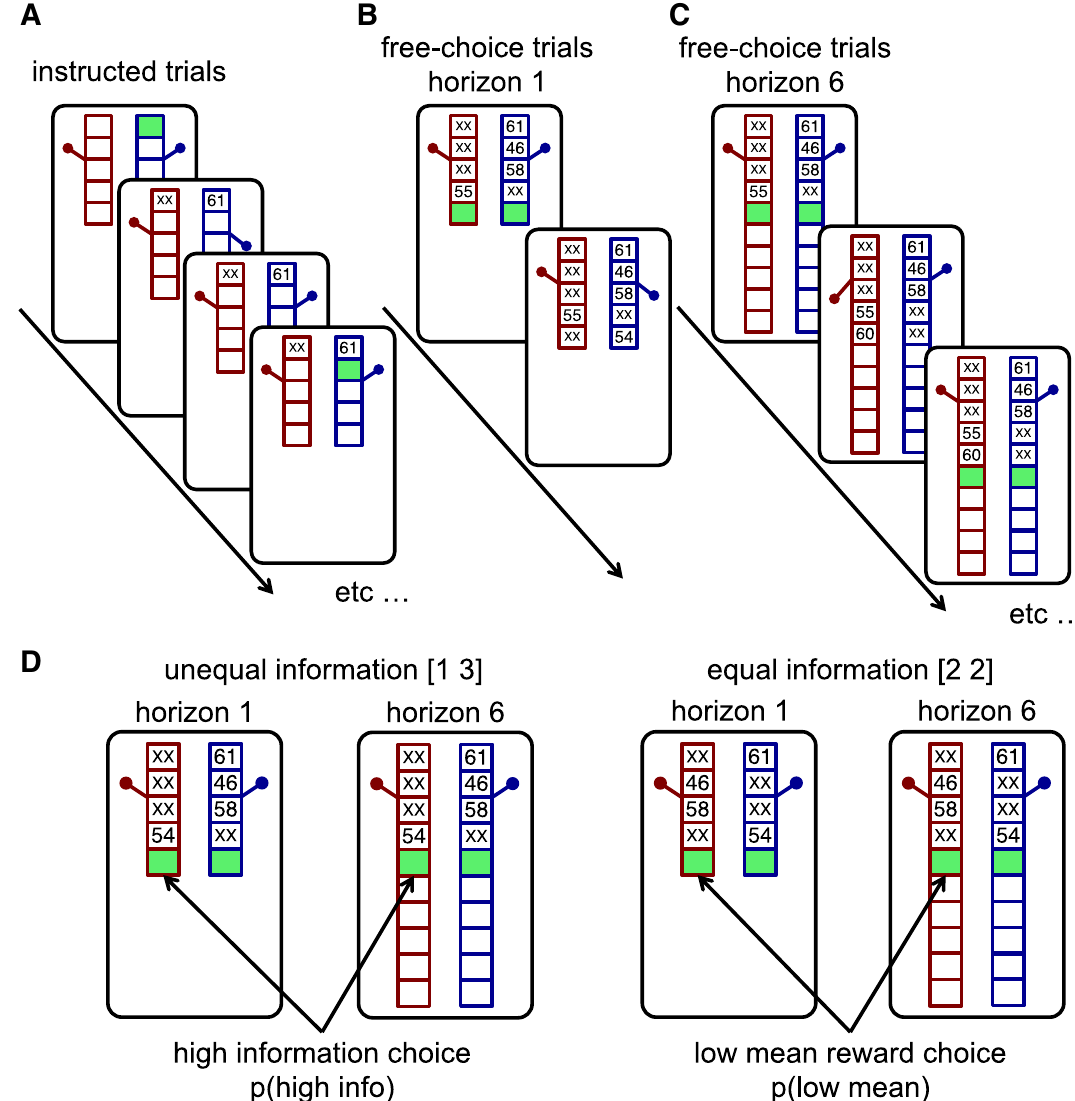
Figure 2. The Horizon Task. ( A ) Each game begins with four instructed trials in which participants are forced to pick the bandit with the green square. Note that the instructed trials are identical across horizon conditions except for the length of the bandits. ( B , C ) After the instructed trials, participants make free choices to the end of the game. In the short horizon condition, the game ends after one free choice ( B ). In the long horizon condition, participants make six free choices to complete the game ( C ). ( D ) The focus of analysis is the first free choice trial. On this trial, behavior is compared between two uncertainty conditions (unequal and equal) and two horizon conditions (short and